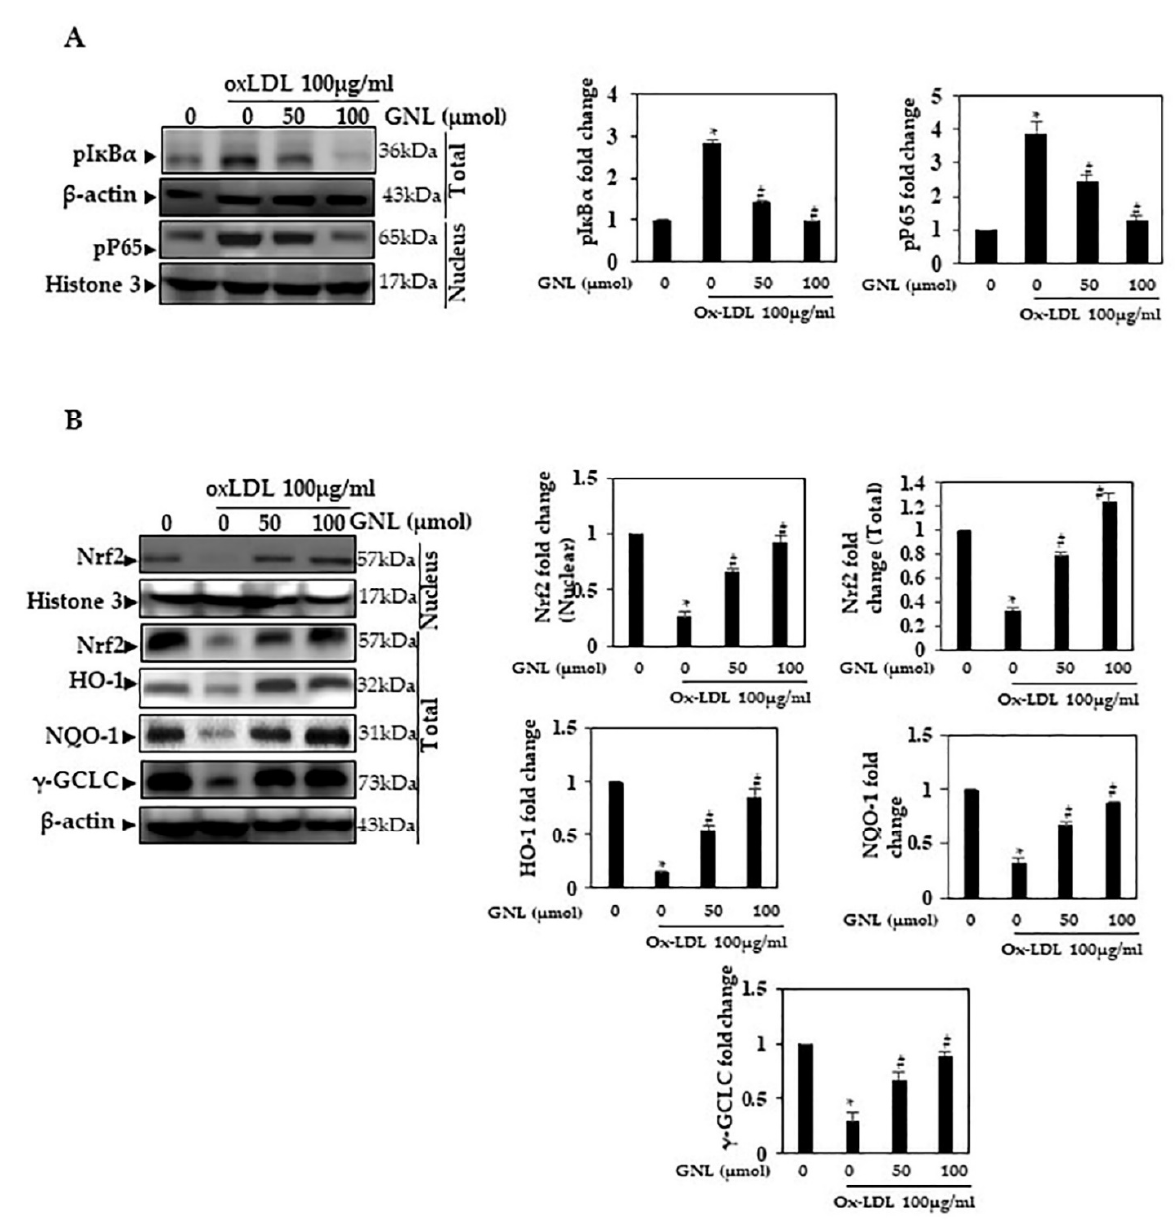
Figure 6. NF- κ B p65 expression is affected by GNL. ( A ) p -I κ B α and pNF- κ B p65 antibodies were used to detect nuclear protein extract and total protein extract on 10–12% SDS-PAGE (polyacrylamide gel electrophoresis). ( B ) By Western blot analysis, we measured the levels of nuclear Nrf2 and NQO-1, HO-1 and γ -GCLC. There are three replicates of each value, and * represents p < 0.05; thus, a significant difference when compared to the control group. The # represents p < 0.05; thus, significant differences between the Ox-LDL alone and GNL with Ox-LDL treatment groups.